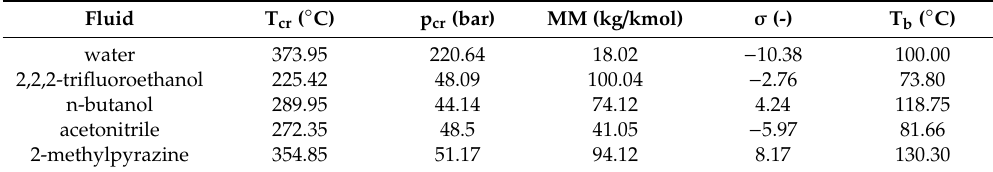
Table 1. Main thermodynamic properties of the investigated working fluids.